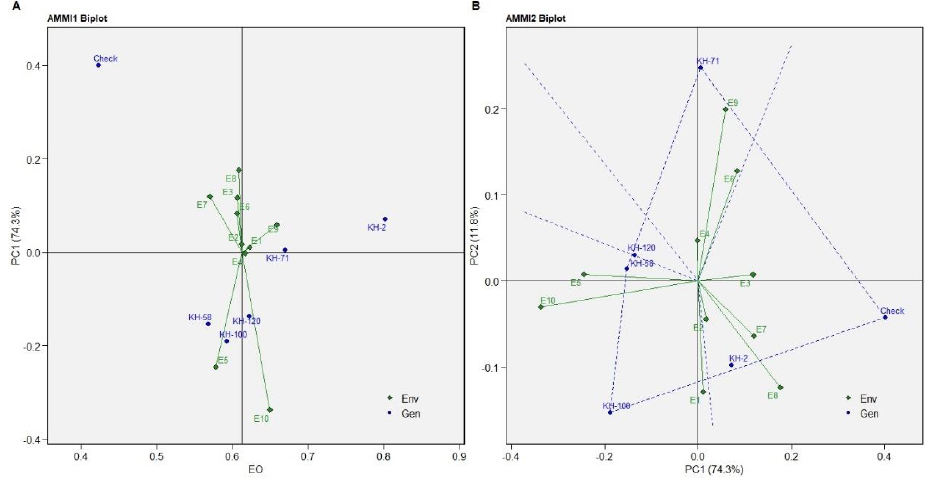
10 of 15 Figure 5 . The genotype ranking through GGE plots for FRY based on ideal genotype for eleven environments.